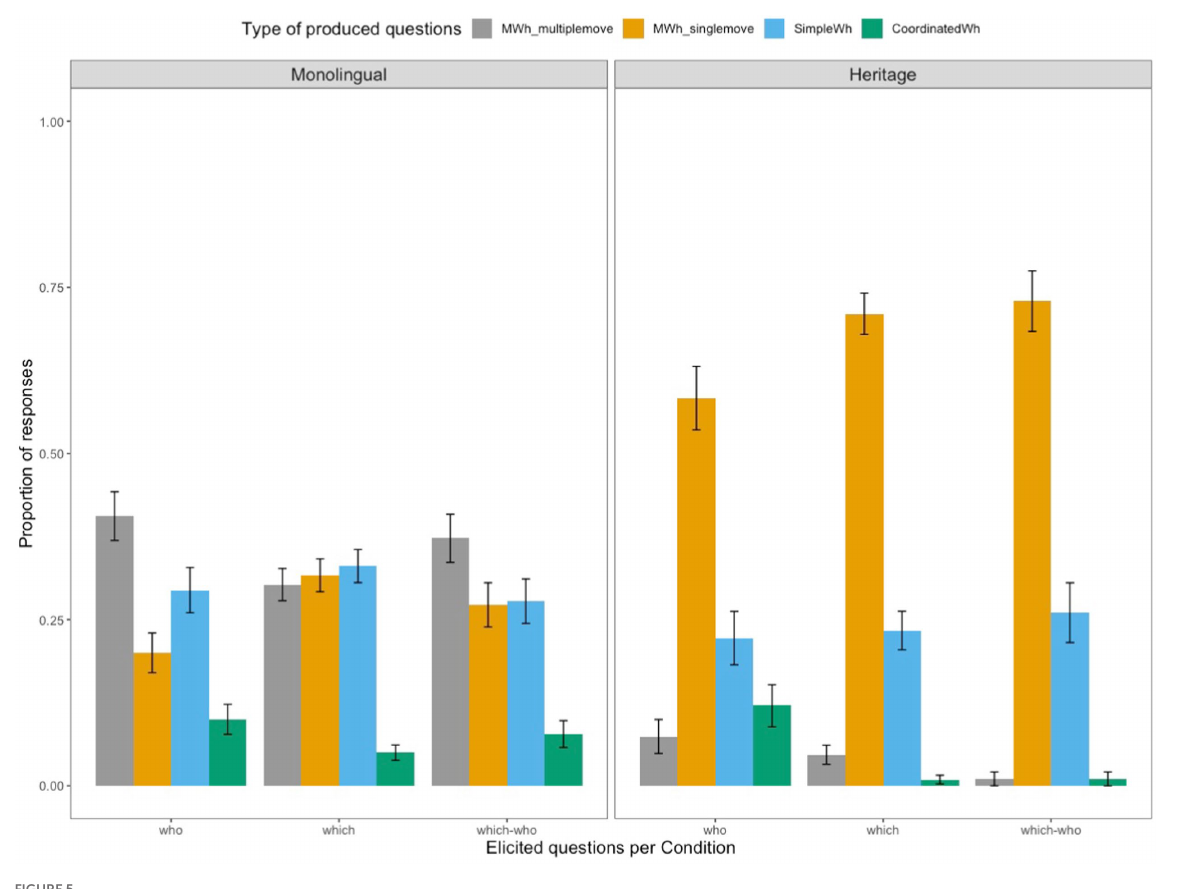
FIGURE 5 Mean production proportion (with standard error bars) for each type of produced question per Group (Monolingual vs. Heritage) and per Question Type (who, which,